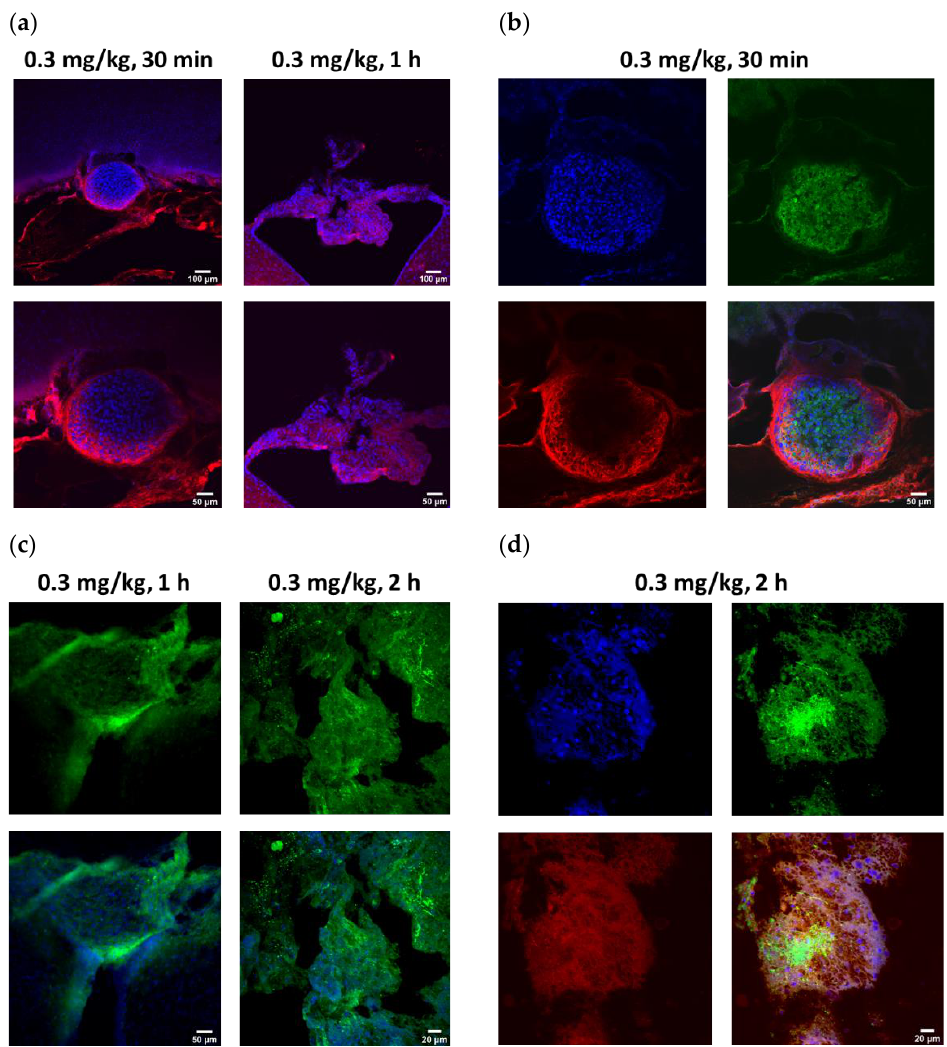
Figure 4. Target Engagement. Intra-CSF injection of U87MGde2,7 tumor cell line followed by next day intra-cisterna magna (ICM) delivery of fluorescently labeled ABT-806 or ABT-414 (FL-ABT-806 or FL-ABT-414) resulted in in vivo binding. Representative images. ( a ) FL-ABT-806 bound to tumor cells after 30 min of intra-CSF delivery. Antibody penetration was limited to the tumor periphery, as evidenced by the red color only on the outer layer of the tumor cluster. The antibody penetrated deeper into the tumor cluster 1 h post-injection, as seen by the red puncta inside. ( b ) To confirm that FL-ABT-806 bound to human tumor cells as opposed to the rat tissue, human-Lamin A + C antibody was used for immunostaining. This antibody colocalized with DAPI only in the tumor cell cluster, thereby confirming the human nature of the cells. Blue = DAPI, Red = FL-ABT-806, Green = Human-Lamin A+C. ( c ) Intra-CSF delivery of FL-ABT-414 resulted in deeper penetration into the tumor cluster 2 h vs. 1 h post-injection, as evidenced by more green puncta inside the tumor. ( d ) ICM administration of a “cocktail” with 1:1 ratio of FL-conjugates of ABT-806: ABT-414 increased penetration of FL-ABT-414 into the tumor cluster core after 2 h of injection, as seen by a higher intensity of green color inside the tumor. Blue = DAPI, Red = FL-ABT-806, Green = FL-ABT-414. n = 3 animals per treatment group.